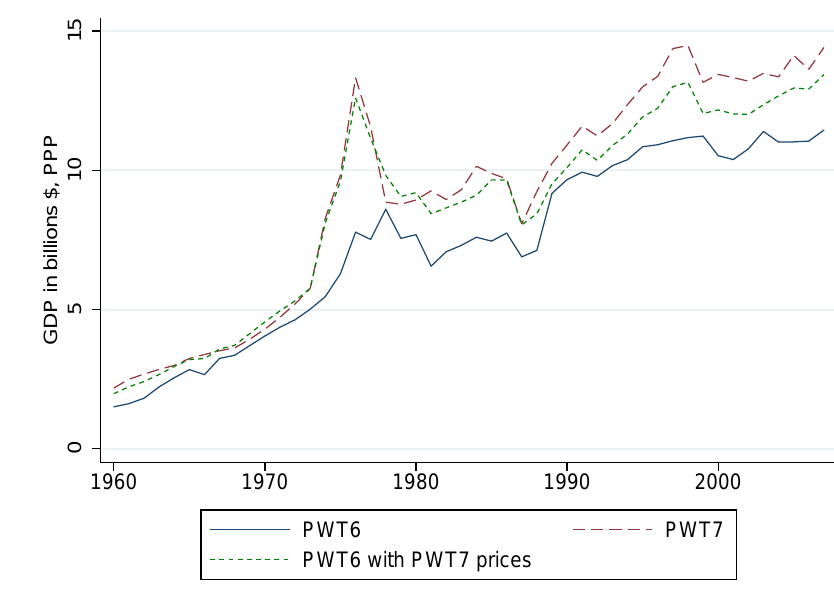
Figure 3: GDP of Gabon according to PWT6 and PWT7,